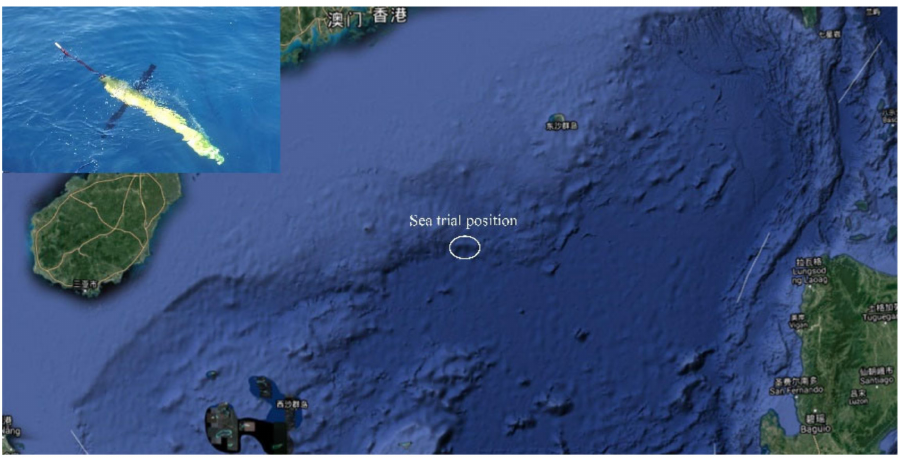
Figure 13. Sea trial